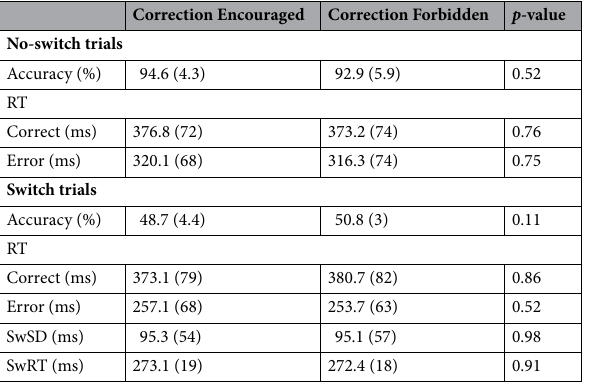
Table 1. Summarized mean values for all behavioral parameters analyzed in the study. We report mean and SD separated for the Encouraged and Forbidden correction